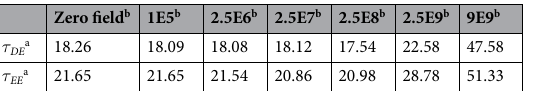
Table 1. The hydrogen bonding lifetimes of DMSO-ethanol and ethanol-ethanol. a The unit of hydrogen bonding lifetime is ps, and the error is ± 5%. b The unit of the intensity of microwave field is V/m .